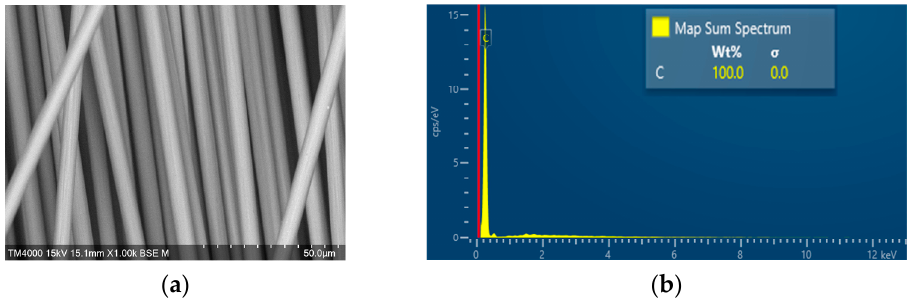
Figure 9. SEM ‐ EDS observation of sizing removed carbon fiber. ( a ) SEM (1000×); ( b ) EDS.